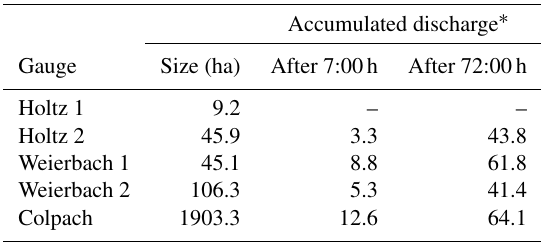
Table 1. Overview of sub-catchment size and accumulated specific discharge as a percentage of the precipitation amount